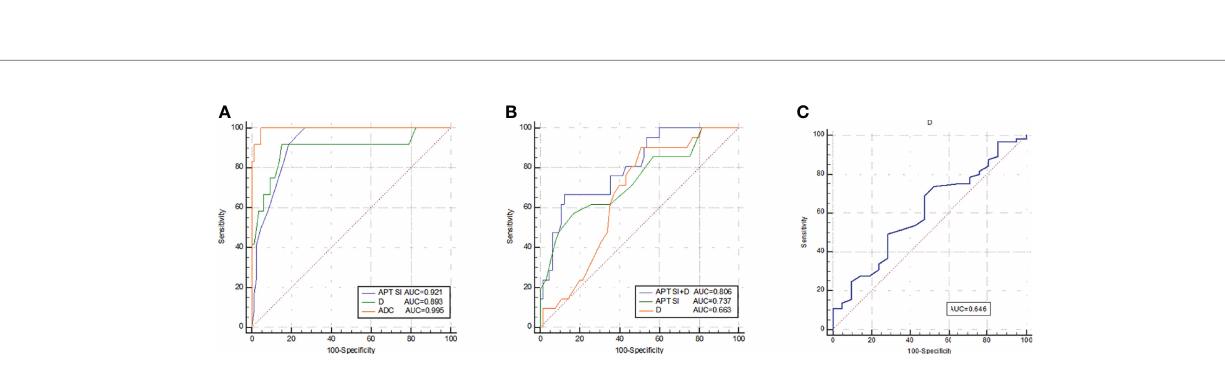
FIGURE 5 | Boxplots of APT SI, D and ADC values in different pathological types, WHO grades, and EMVI statuses of tumors. The APT SIs (A) 、 D (B) and ADC (C) values were signi fi cantly higher in MC than in AC. In AC group, the APT SIs (D) were signi fi cantly lower in low-grade than in high-grade group, and the D values (E) were signi fi cantly higher than in high-grade group. The D values (F) were signi fi cantly lower in positive EMVI than negative EMVI.